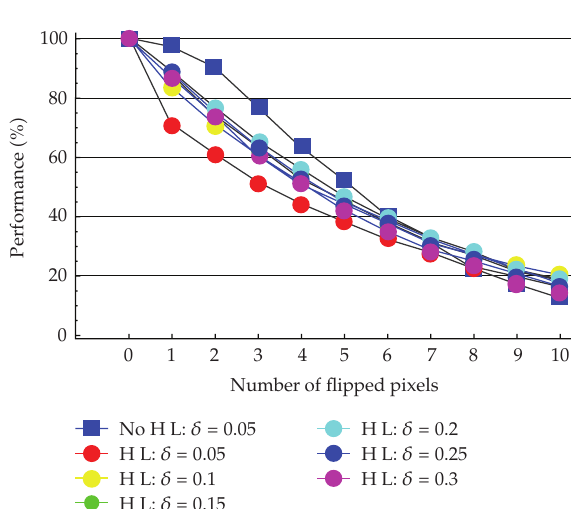
Figure 14: Comparison between the transmission function with (cid:3) disks (cid:4) or without hard limits (cid:3) square (cid:4) in function of various values of